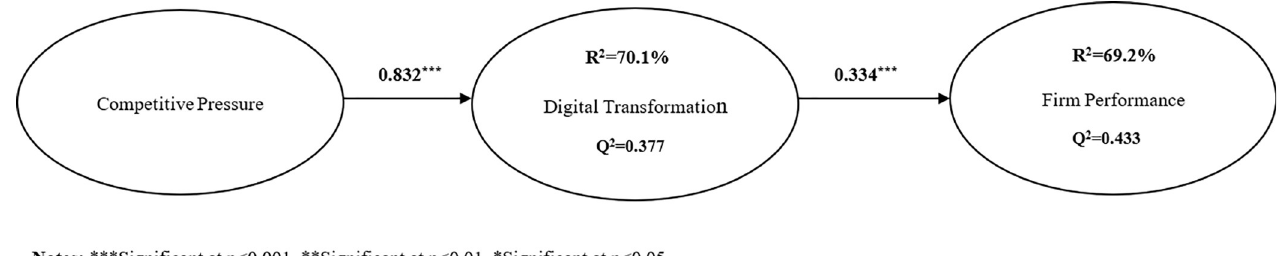
Fig 3. Structural model results in Study 1. Notes: *** Significant at p < 0.001, ** Significant at p < 0.01, * Significant at p < 0.05.